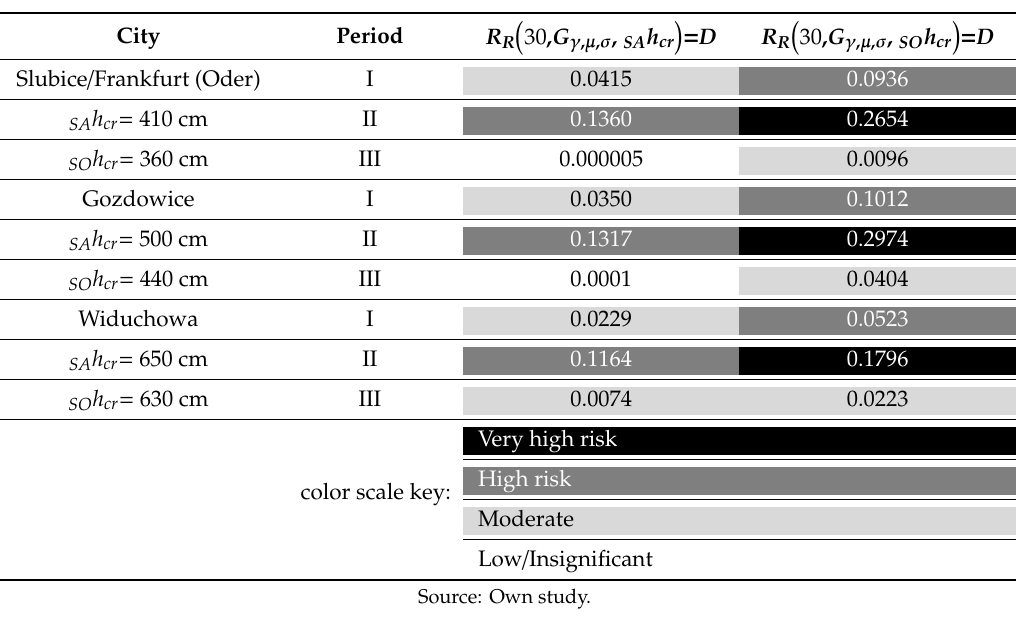
Table 3. Risk measurements for each individual areas in periods I-III estimated based on the probabilistic model of flood risk.